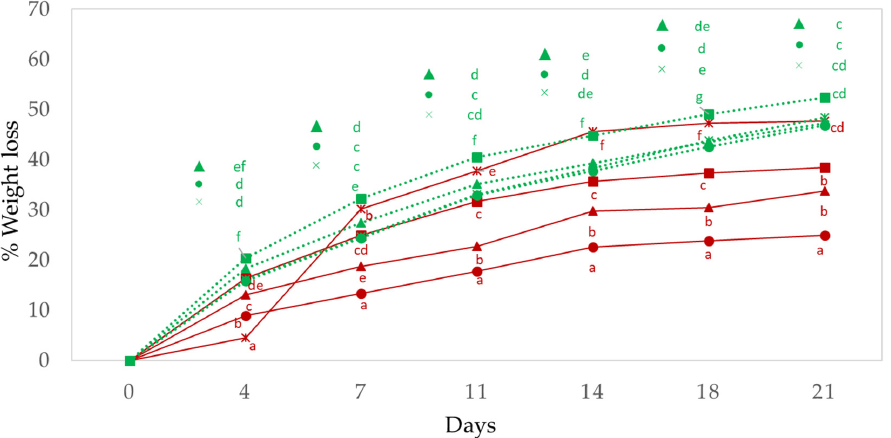
Figure 1. The effect of replacing pork backfat with high oleic sunflower oil on weight losses in the traditional and reduced fat “Chorizo Zamorano” during ripening. Traditional: ( (cid:4) ) Control, ( (cid:78) ) 12.5%, ( • ) 20%, and ( × ) 50% of backfat replacement. Reduced fat: ( (cid:4) ) Control, ( (cid:78) ) 12.5%, ( • ) 20%, and ( × ) 50% of backfat replacement. a, b, c, d, e, f, mean statistically significant differences between batches for the same day of